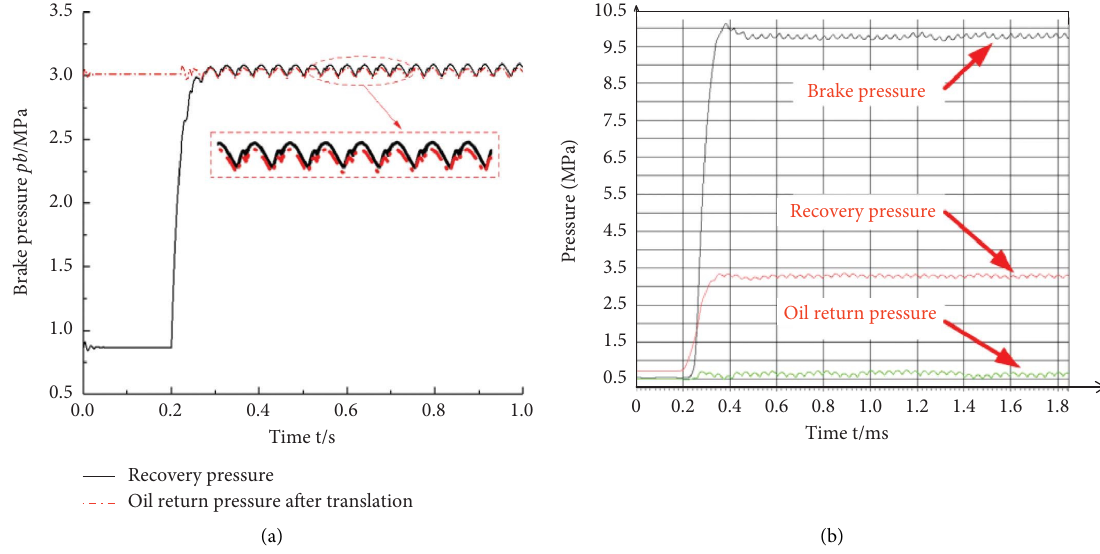
Figure 7: Recovery pressure p c for oscillation. (a) Simulation results. (b) Experimental test